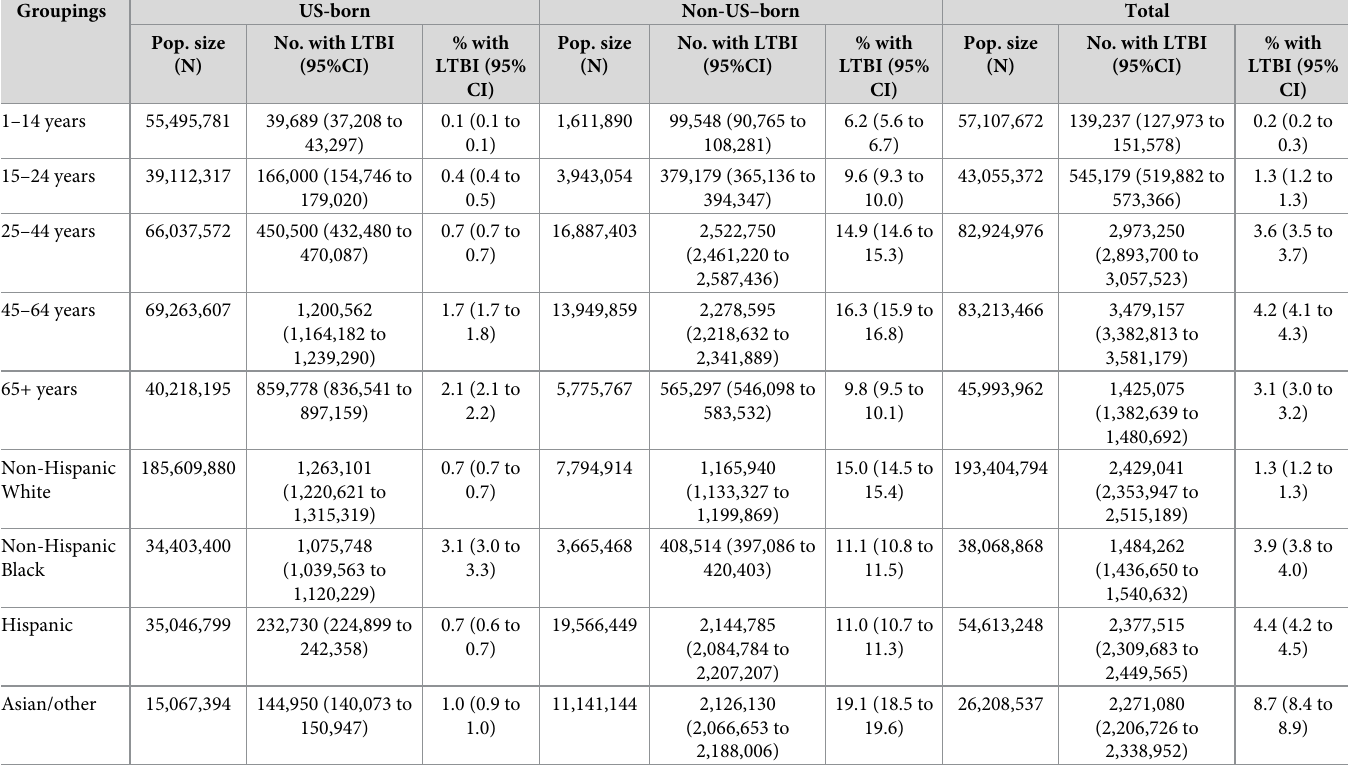
Table 4. Estimated prevalence of latent tuberculosis infection in the United States in 2015 within age group and race/ethnicity, stratified by nativity and in total population. Groupings US-born